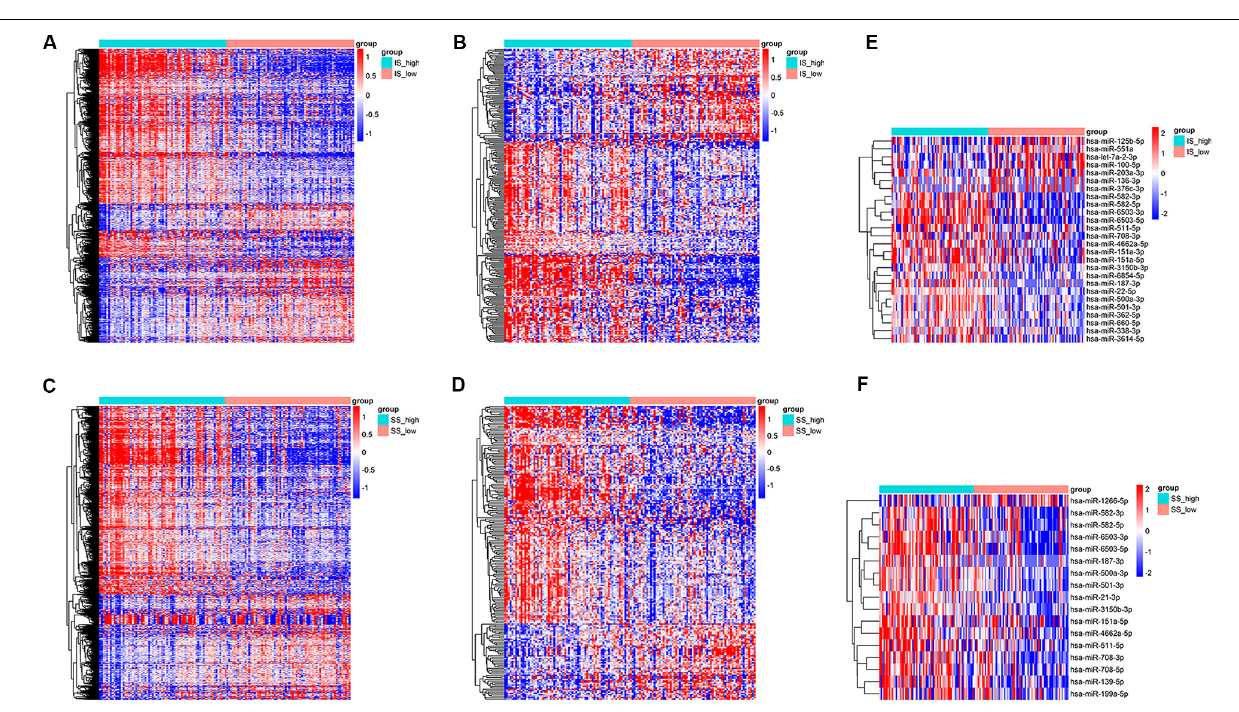
( Figure 2B ) based on immune scores, and 1166 mRNAs ( Figure 2C ) and 212 lncRNAs ( Figure 2D ) based on stromal scores. Setting the cut-off criteria as |log FC| > 2